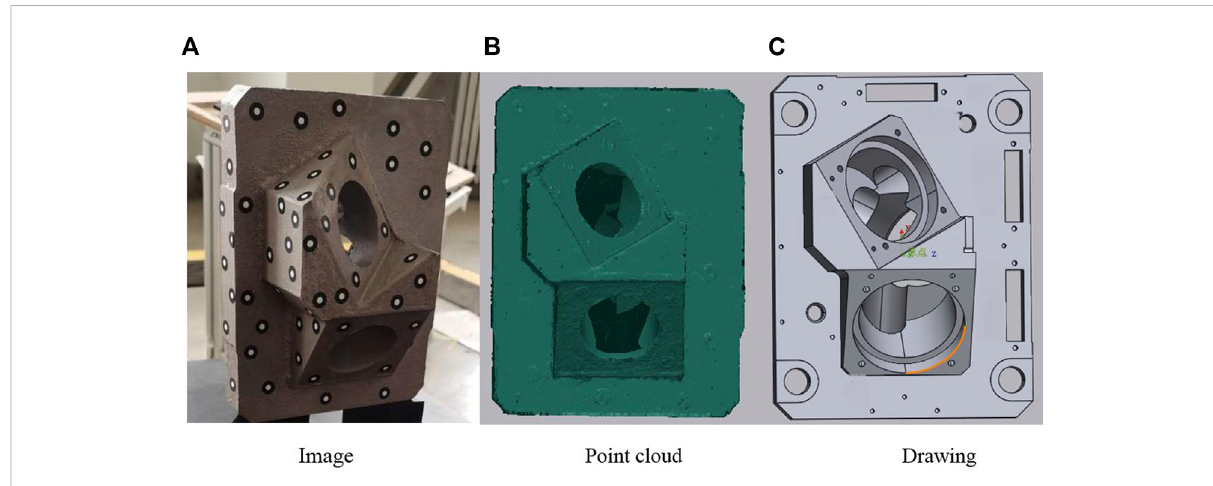
FIGURE 8 Workpiece used for the experiment. (A) Workpiece. (B) Point cloud of the workpiece. (C) 3D designed drawing of the workpiece.